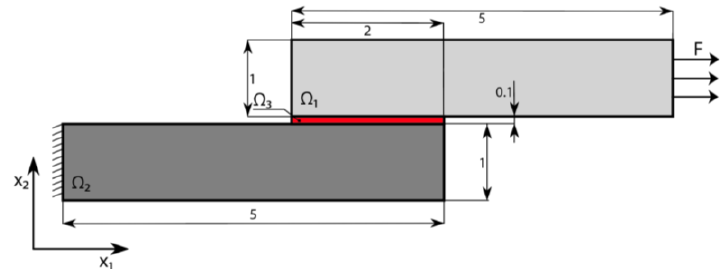
Figure 9. Construction of the package and boundary conditions (Unit: mm).